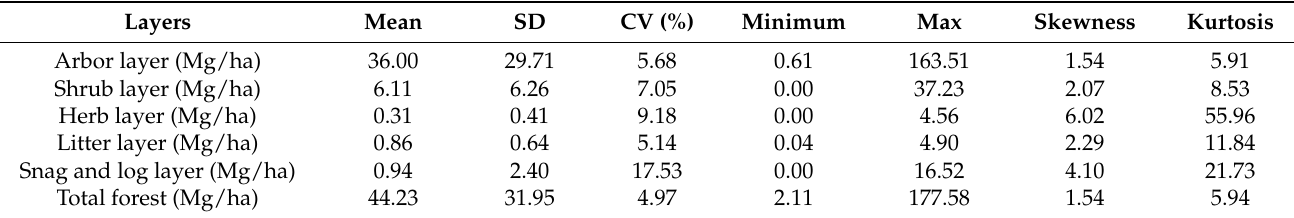
Table 4. Mean, standard deviation (SD), coefficient of variation (CV), minimum, maximum, range, skewness and kurtosis of vegetation carbon